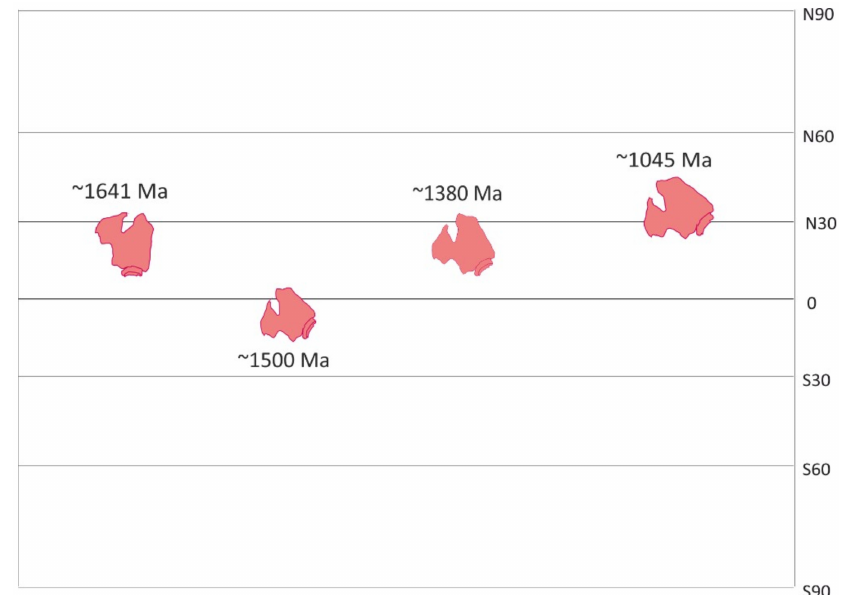
Figure 9. Reconstruction of the latitude position of Siberia 1380 Ma and comparison of latitudinal movement of Siberia in the Mesoproterozoic. For paleomagnetic reconstruction we used the following